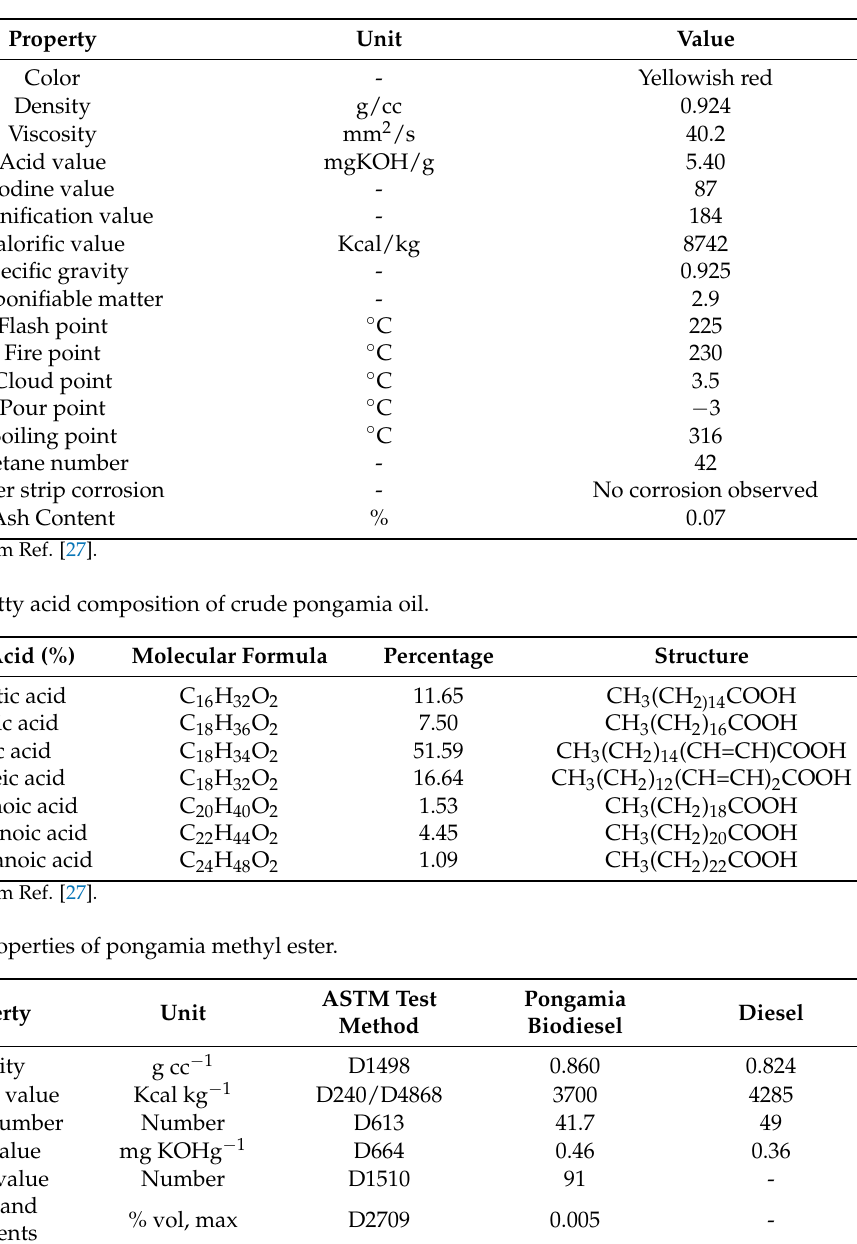
Table 2. Physio-chemical properties of crude pongamia oil.